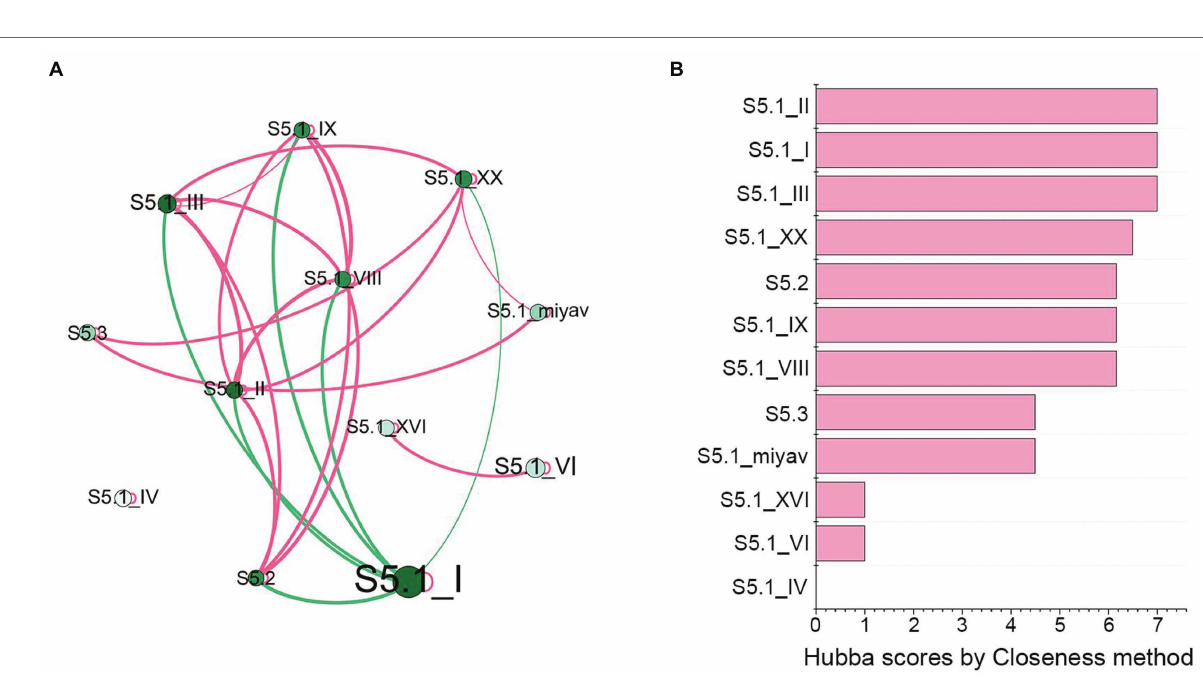
FIGURE 4 | Co-occurrence patterns of Synechococcus genotypes. (A) The co-occurrence network of Synechococcus clades. The size of node represents its average percentage in all samples; the lightness of node represents its degree; the thickness of the edge represents its weight; the red edges represent positive correlations, and the green edges represent negative correlations. (B) Hubba scores ranked by the Closeness method represent the significance of each